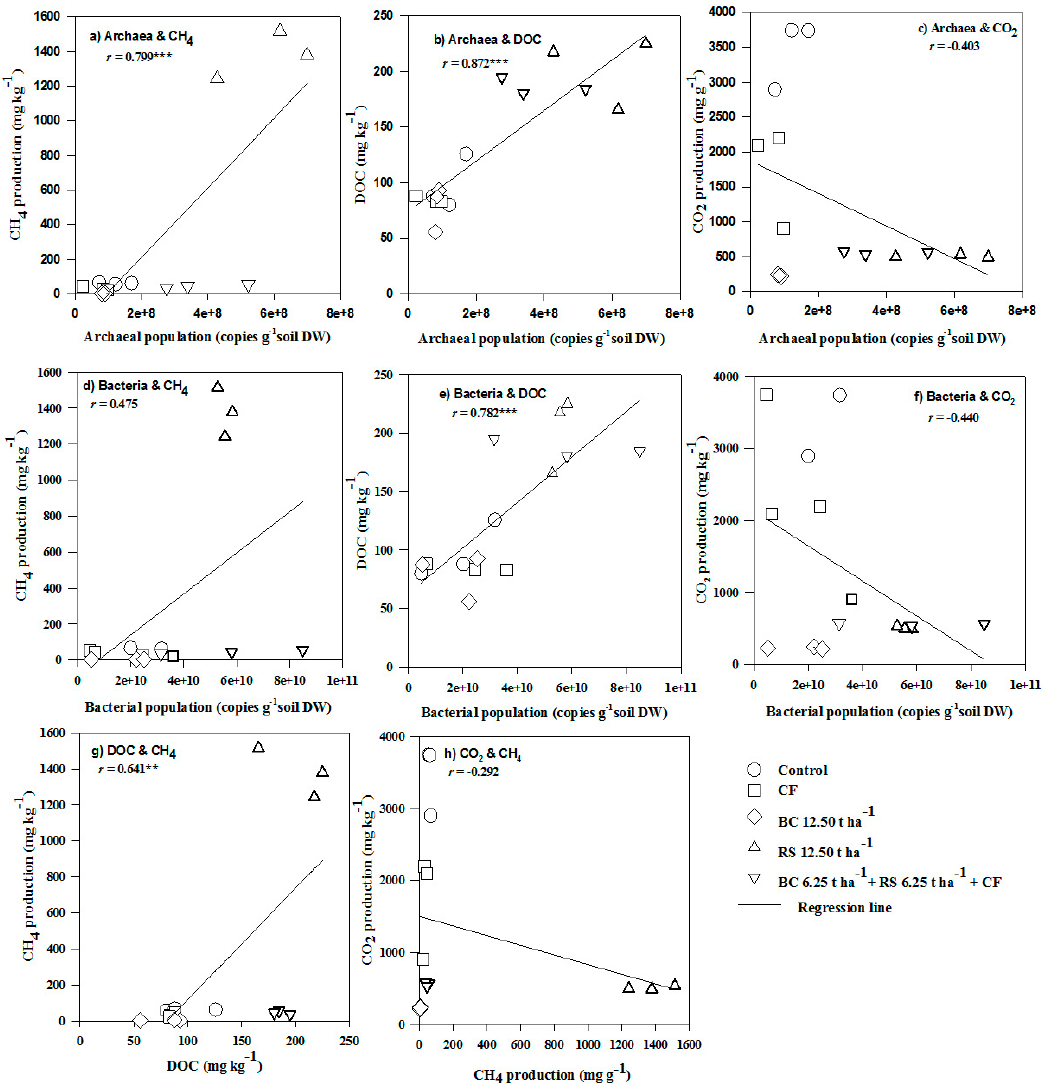
Figure 2. The correlation coefficients between Archaeal and CH 4 production ( a ), DOC content ( b ) and CO 2 production ( c ); between Bacterial abundance and CH 4 production ( d ), DOC content ( e ) and CO 2 production ( f ); between DOC content and CH 4 production ( g ); and between CH 4 and CO 2 production ( h ). ** Very significant at p -value < 0.01, *** extremely significant at p -value < 0.001, n = 15.